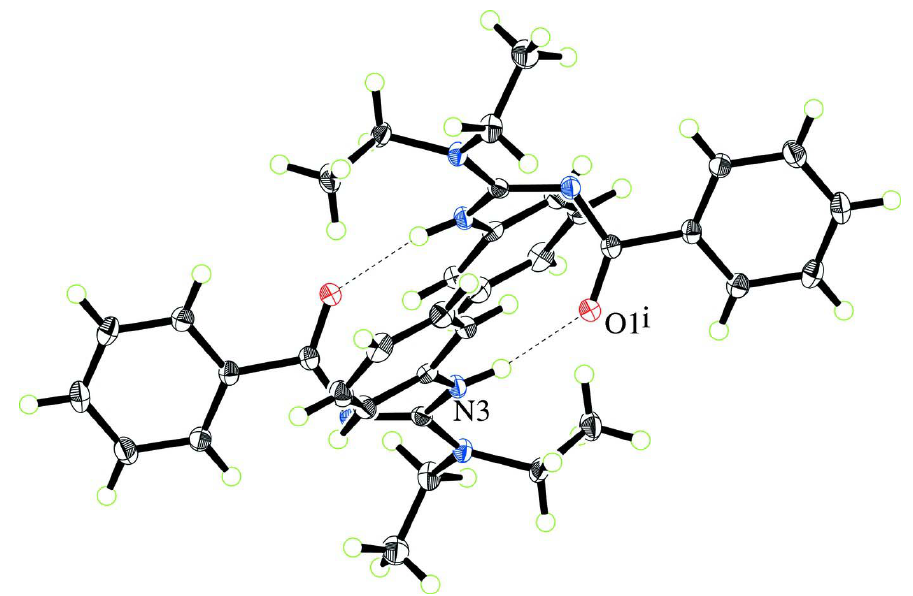
Figure 2 A view of the centrosymmetric hydrogen-bonded dimer structure of compound (I) [Hydrogen bonds shown as dashed lines; symmetry code: (i) - x , 1 - y , 1 - z